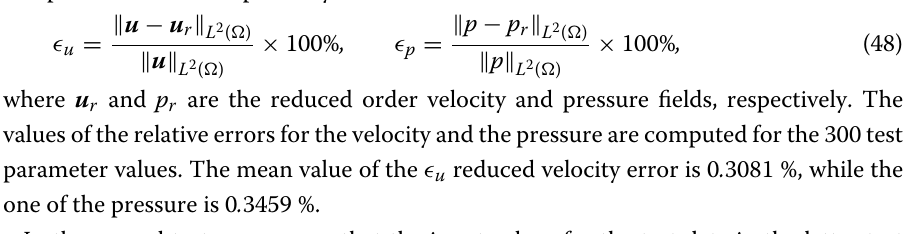
values of the relative errors for the velocity and the pressure are computed for the 300 test parameter values. The mean value of the (cid:6) u reduced velocity error is 0 . 3081 %, while the one of the pressure is 0 . 3459